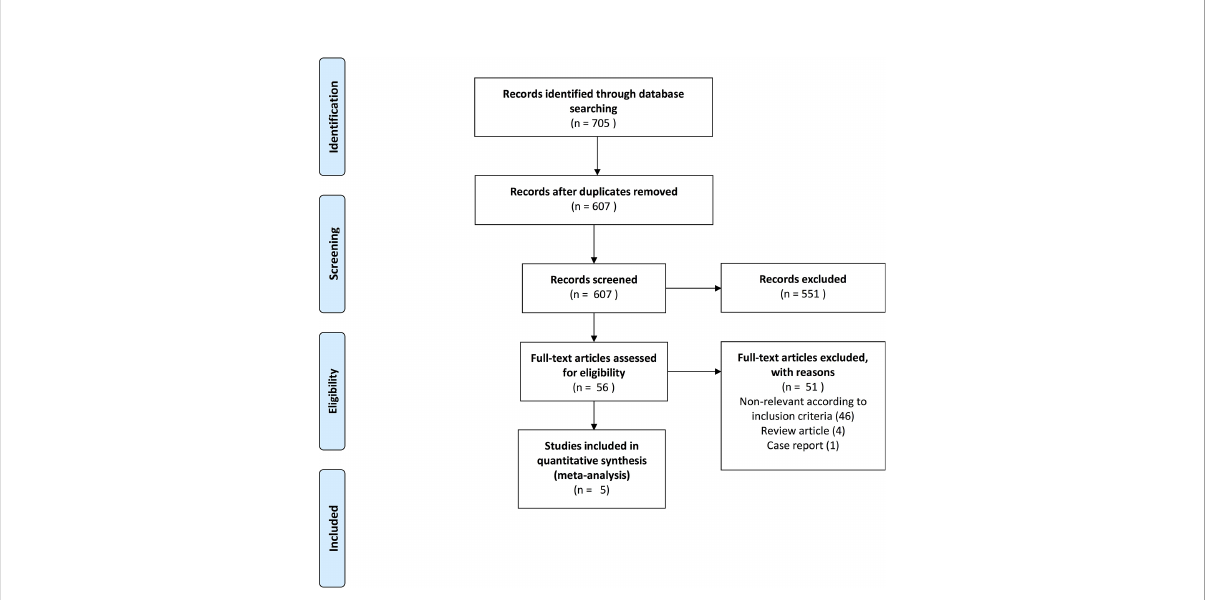
FIGURE 1 PRISMA (Preferred Reporting Items for Systematic Reviews and Meta-Analyses) fl ow chart depicting included studies for the meta-analysis addressing overall survival, progression-free survival and duration of response of fi rst-line therapy in mRCC